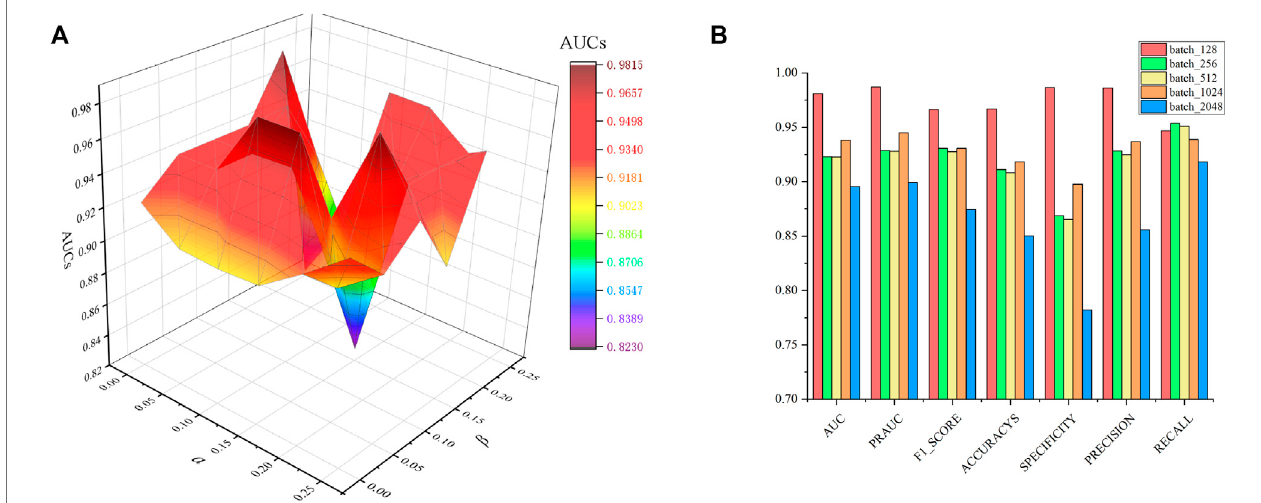
FIGURE 2 | Parametric analysis, (A) effects α and β on prediction accuracy, and (B) effect of batch size.